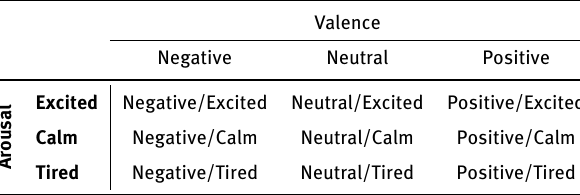
Table 1: Nine classes reflecting possible combinations of valence- arousal